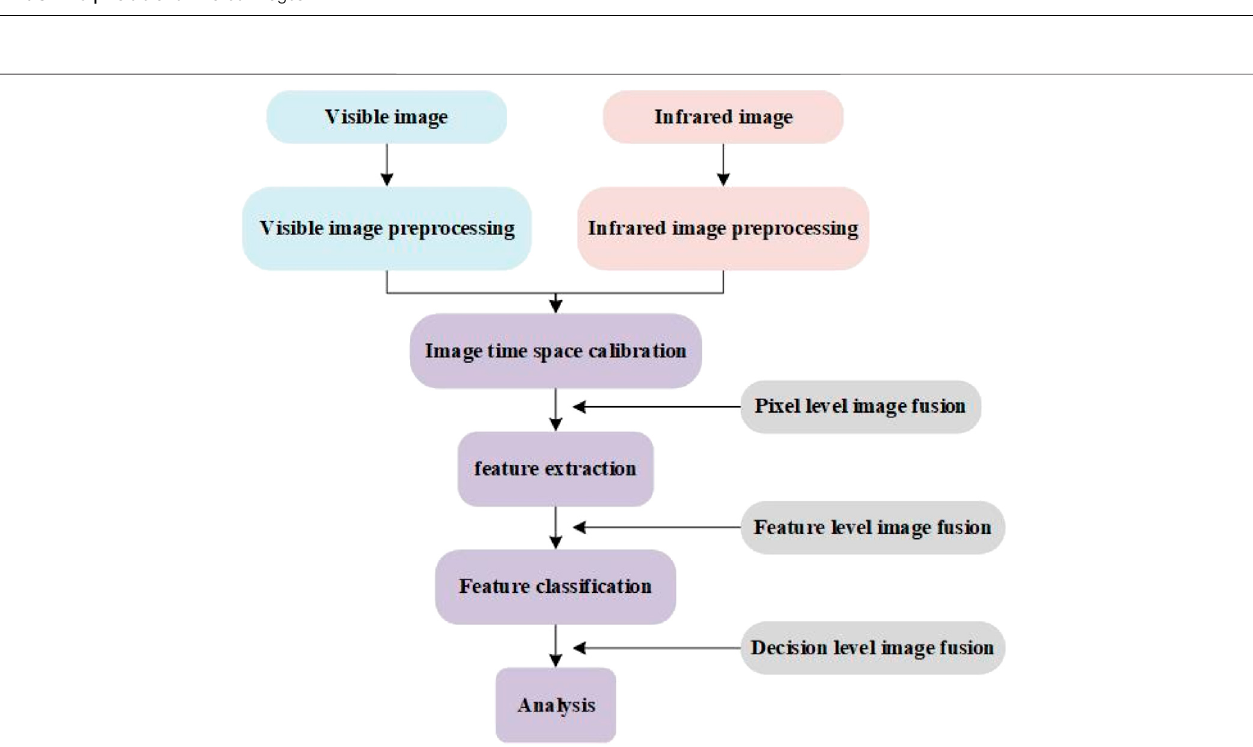
FIGURE 6 | Visible and infrared image fusion